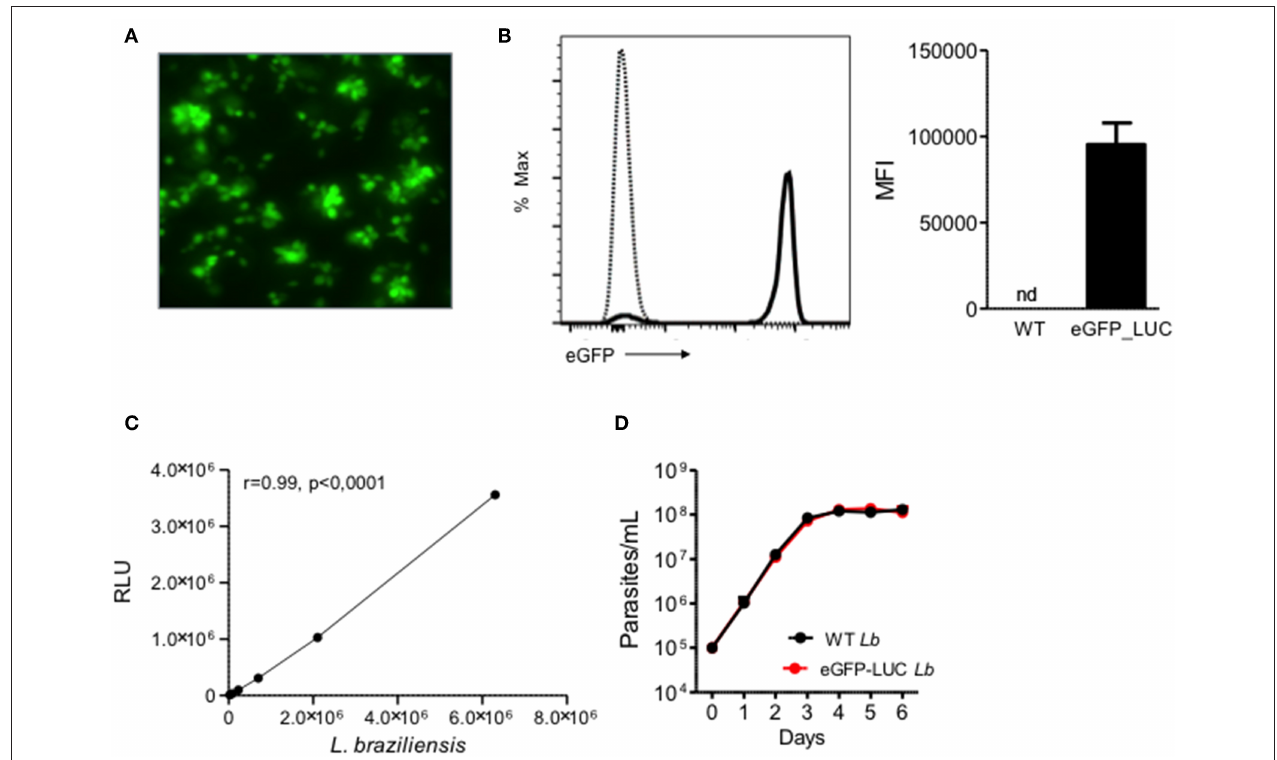
FIGURE 3 | Expression of eGFP and Luciferase in transgenic L. braziliensis. (A) Fluorescence microscopy of transgenic L. braziliensis (clone #7) promastigotes. (B) Representative histogram depicting eGFP in WT L. braziliensis (dotted line) and eGFP-LUC L. braziliensis (clone #7) (solid line), both shown as % of Max. Bar graph represents the MFI of WT and eGFP-LUC L. braziliensis . Data (mean ± SEM) are from a representative experiment. (C) Luminescence intensity and number of eGFP-LUC L. braziliensis promastigotes. Promastigotes were serially diluted and luminescence was measured using a microplate reader, after addition of luciferin. RLU, relative light units. (D) Growth curve of WT and eGFP-LUC L. braziliensis (clone #7). Parasites were cultures in supplemented Schneider medium and parasites numbers were determined daily using a hemocytometer. Data (mean ± SEM) are from a representative experiment, performed in quintuplicate. nd, not detected.